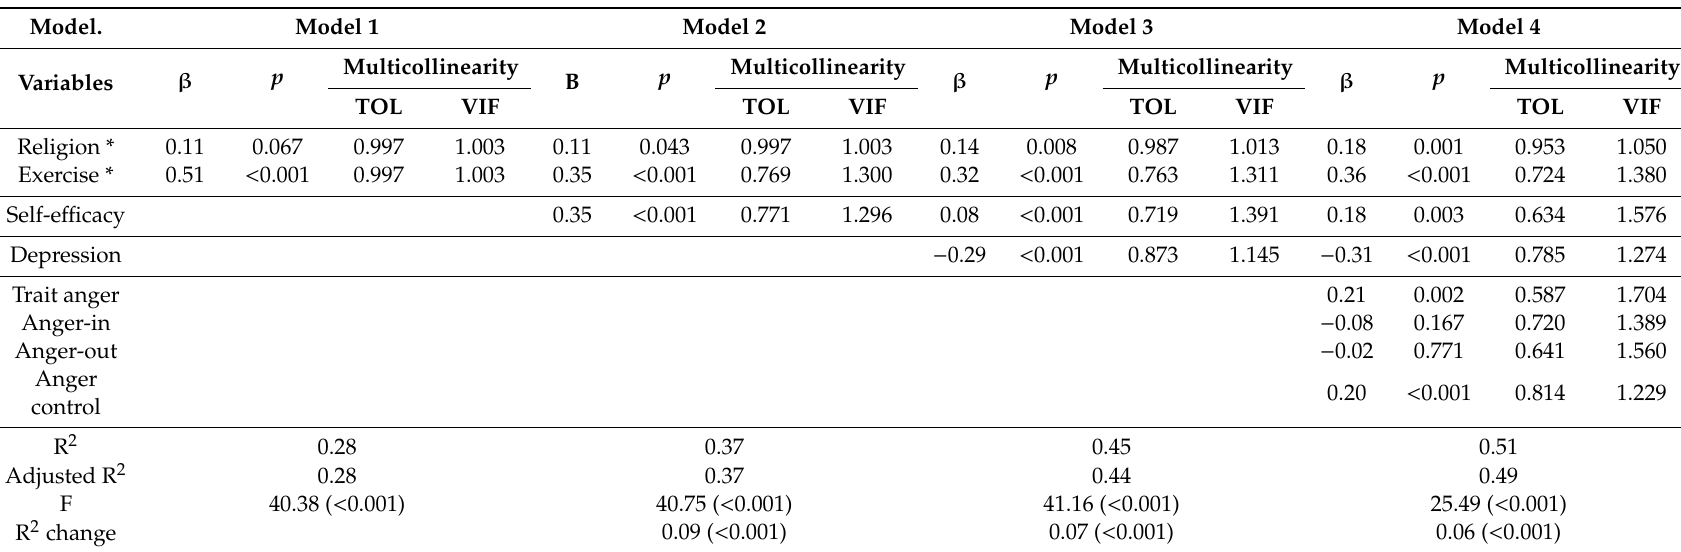
Table 5. Hierarchical multiple regression analysis of factors influencing health-promoting behaviors (N =